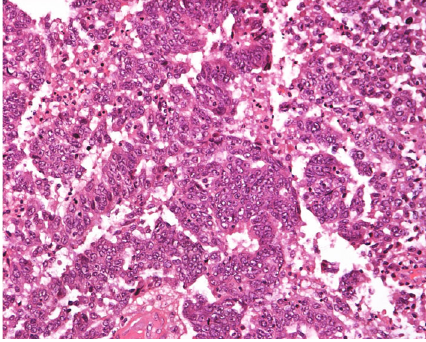
Figure 2: Cystic and solid mass with micropapillary con fi